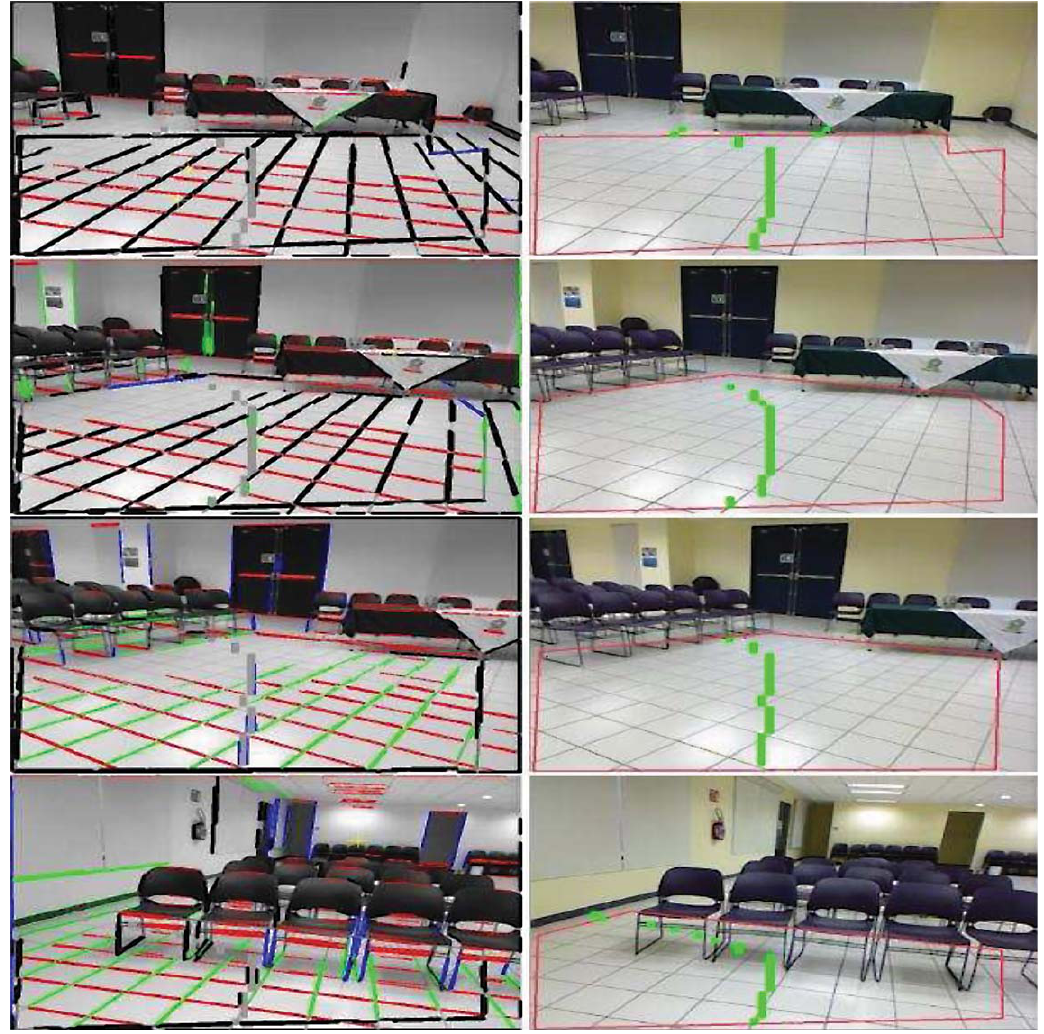
Fig. 18. Navigation path avoiding obstacles: a succession of paths generated by the inference engine processing in real time using the stereo data, vanishing points, and the obstacle’s location on the floor